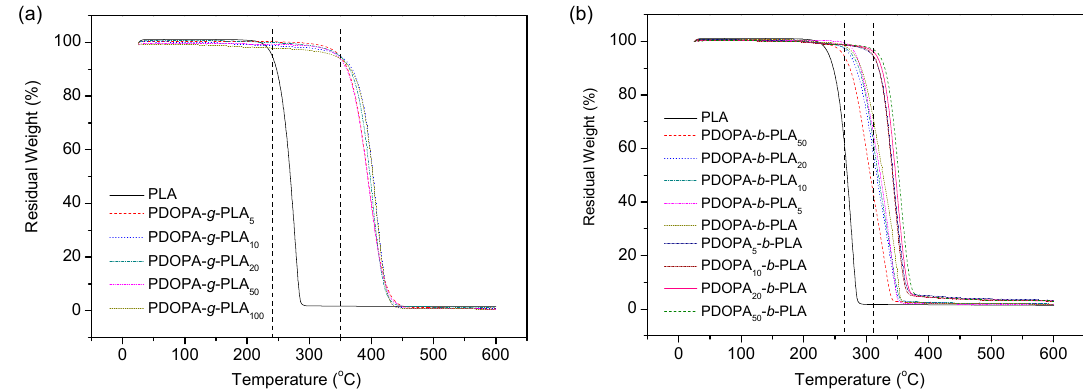
Figure 3. TGA curves of the PDOPA- g -PLA ( a ), and PDOPA- b -PLA ( b ) copolymers with various compositions under N 2 .